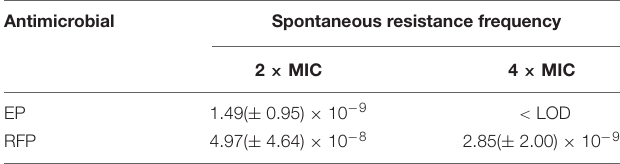
TABLE 2 | Single-step resistance selection of EP for S. aureus USA300.